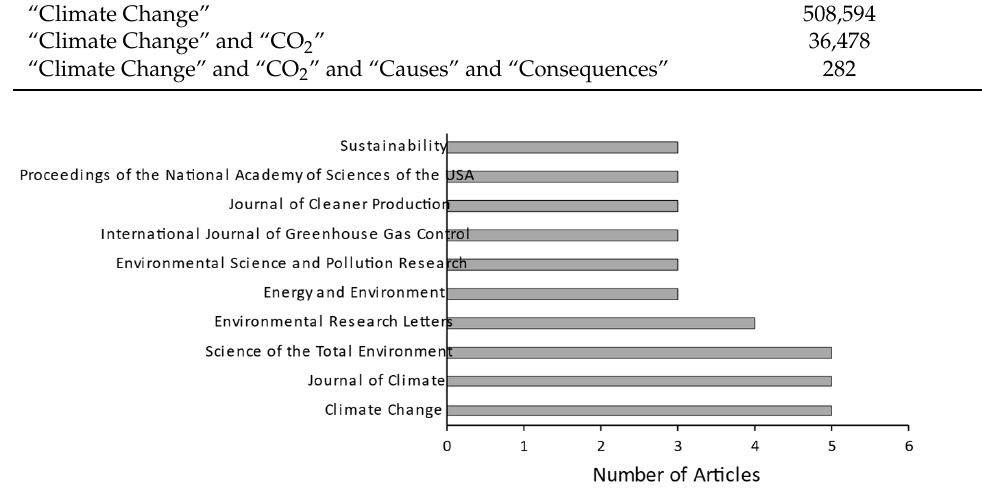
Figure 1. Main sources with three or more articles published on the subject.